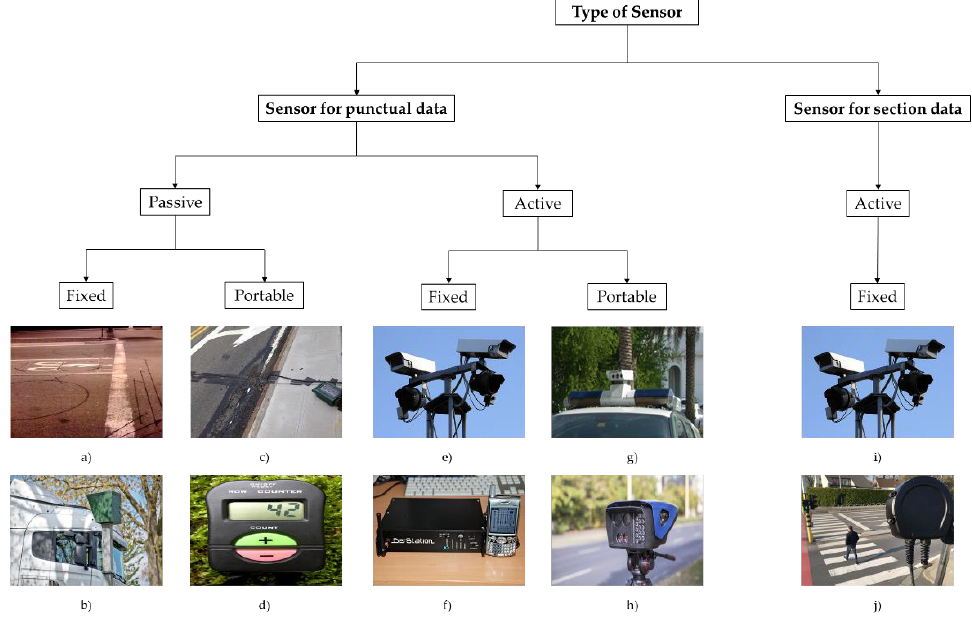
Figure 1. Classification and examples of sensors according to the characteristics of the collected data, their interaction with the vehicle and position on the road: ( a ) Inductive loop detector; ( b ) Microwave radar; ( c ) Rubber hoses detector; ( d ) Hand electronic counter; ( e ) and ( i ) Automatic Number Plate Recognition (ANPR) fixed sensors; ( f ) Bluetooth sniffer; ( g ) Police ANPR sensor on vehicle; ( h ) Police ANPR portable sensor; ( j ) Bluetooth scanning sensor.